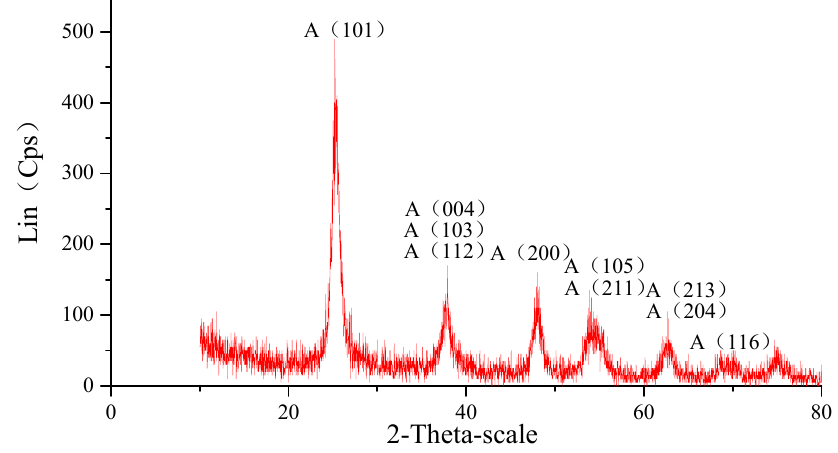
Figure 2. XRD pattern of the TiO 2 nanoparticles.